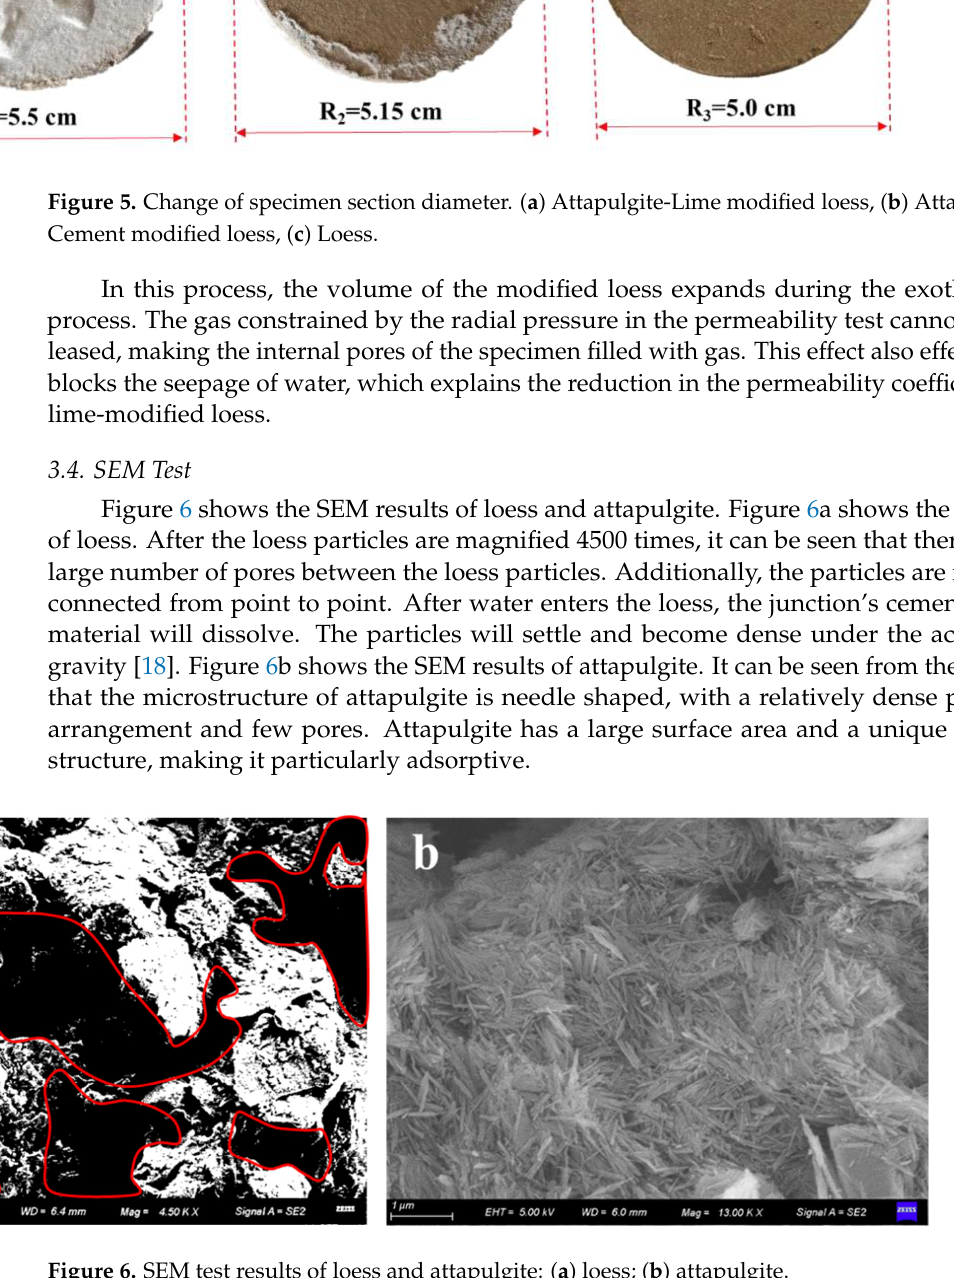
Figure 7. SEM test results of modified loess: ( a ) attapulgite-modified loess, ( b ) attapulgite-lime- modified loess, and ( c ) attapulgite-cement-modified loess. Moreover, attapulgite has a needle-like structure, resulting in a reinforcement effect when combined with loess, making them a flake whole. Figure 7b,c shows the microstruc- ture of attapulgite-lime-modified loess and attapulgite-cement-modified loess, respec- tively. It can be seen from the figure that after adding lime and cement, loess particles coalesced into larger structures, especially after adding cement, and the effect was most apparent. Moreover, Figure 7c shows that the loess surface modified by cement atta- pulgite is smoother and flat. In the region of the yellow amplification, it can be seen clearly